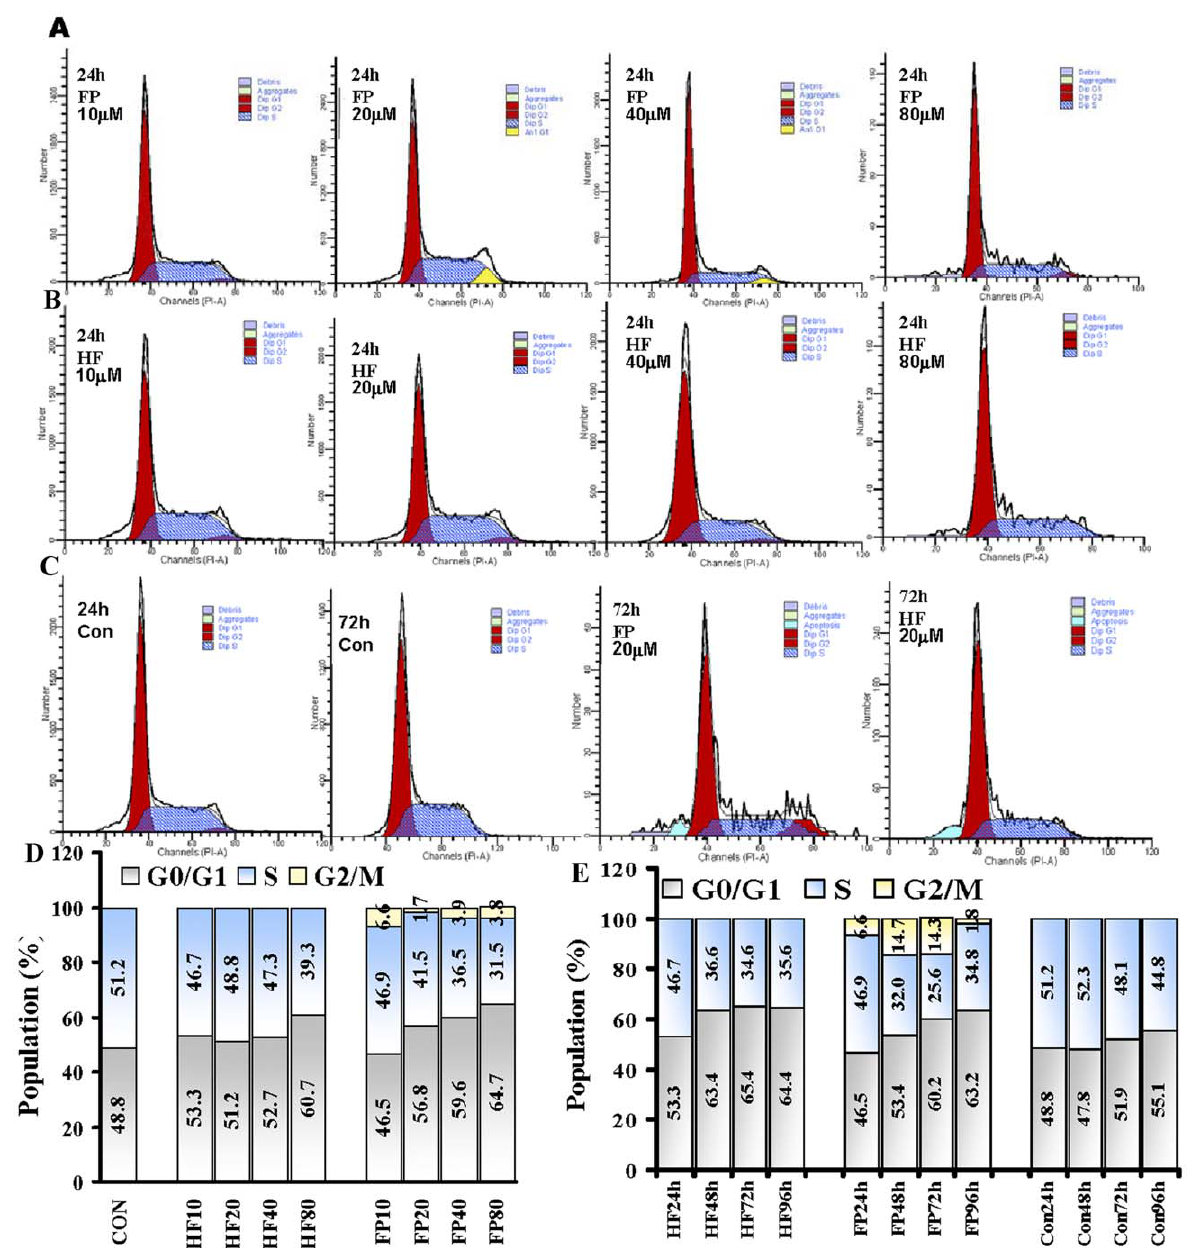
Figure 2. Effects of FP/HF on cell cycle distribution. HeLa cells were treated with different concentrations of FP/HF for 24, 48, 72 and 96 h. Cells were harvested and stained with propidium iodide. Cell cycle distribution was analyzed using a BD FACSCanto II flow cytometer. The distributions of cells in G0/G1, S, and G2/M phases were determined using Modfit software. A) Representative cell cycle distributions after treatment with FP at 10, 20, 40 and 80 m M for 24 h. B) Representative cell cycle distributions after treatment with HF at 10, 20, 40 and 80 m M for 24 h. C) Representative cell cycle distributions after treatment with 20 m M FP/HF at 72 h and control at 24 and 72 h. D) G0/G1, S and G2/M population percentages in each group following treatment with 10, 20, 40 and 80 m M HF or FP for 24 h. E) G0/G1, S and G2/M population percentages in each group following treatment with 20 m M HF or FP and control group for 24, 48, 72 and 96 h.